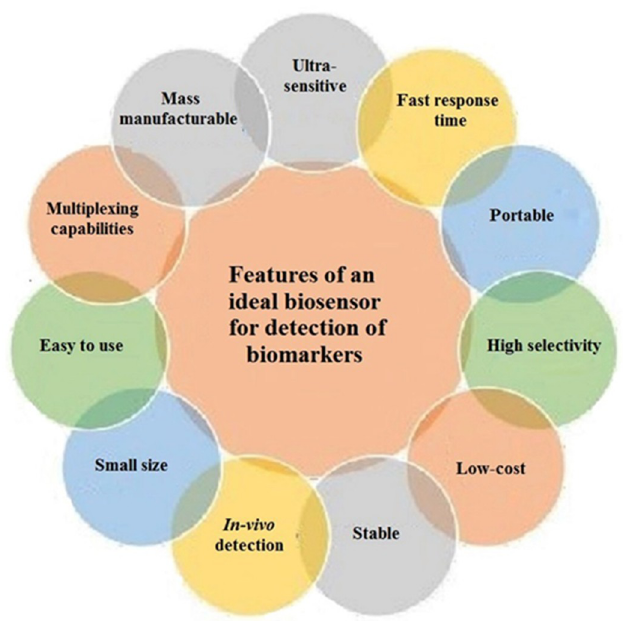
Figure 6. An ideal feature of an electrochemical sensor in clinics (Reproduced with permission from ref. [113]).